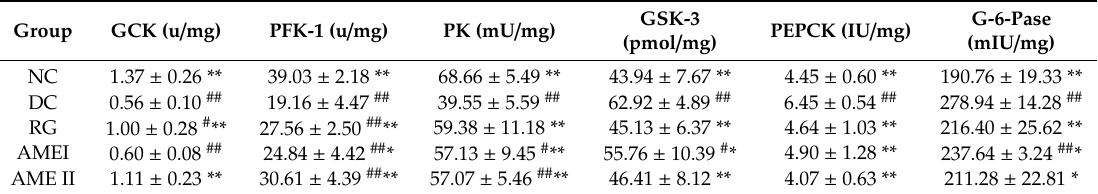
Table 7. E ff ects of AME on the activity of glucose metabolic enzymes in liver of diabetic mice ( n = 10).